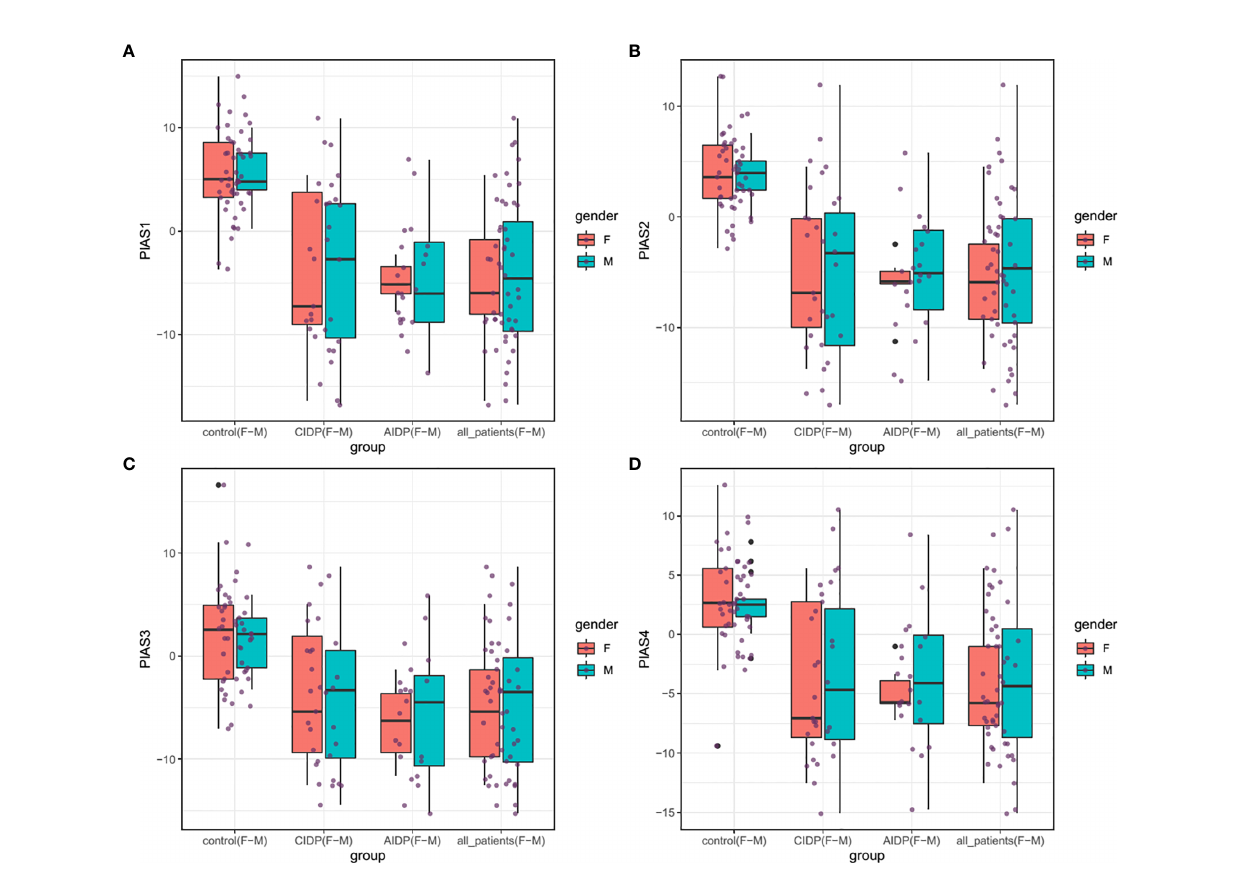
FIGURE 1 | Relative expressions of PIAS genes in AIDP/CIDP patients and healthy subjects. Depicted box plots and whiskers show all data points from maximum to minimum. Boxes are depicted from Q1 to Q3. The horizontal lines in the middle of boxes show the median values. Each black dot shows expression in a certain sample. Mean values and interquartile range are displayed.